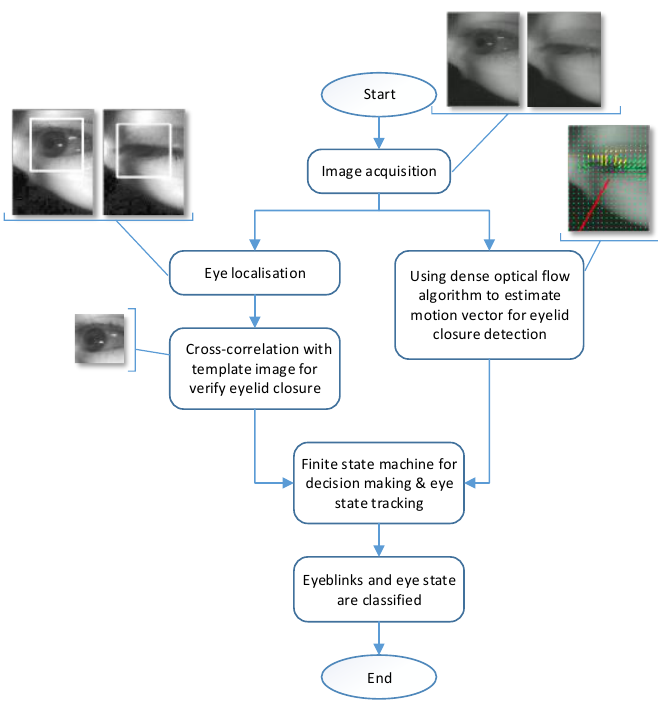
Figure 10. The structure for our eyeblink detection algorithm.